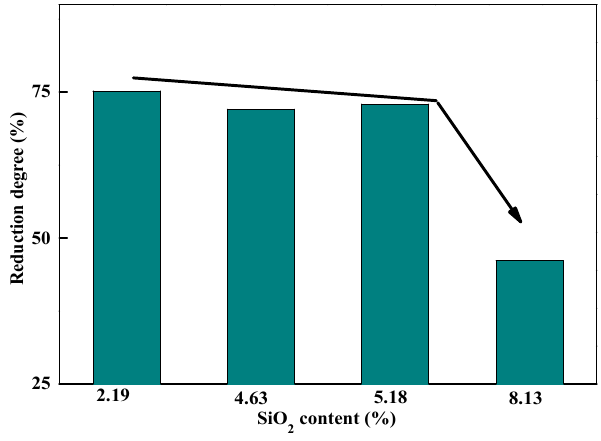
ff ect of SiO 2 on the reduction degree of Figure 7. Effect of SiO 2 on the reduction degree of pellets. Figure 7. E